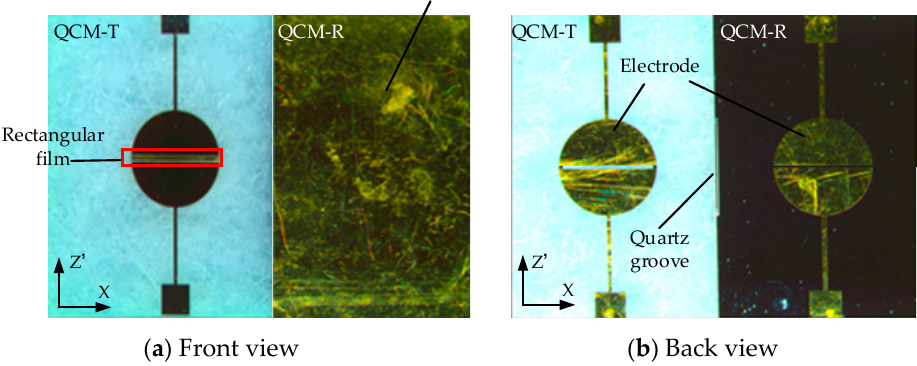
Figure 5. Example pictures of the fabricated dual-channel LFE-QCM chip.